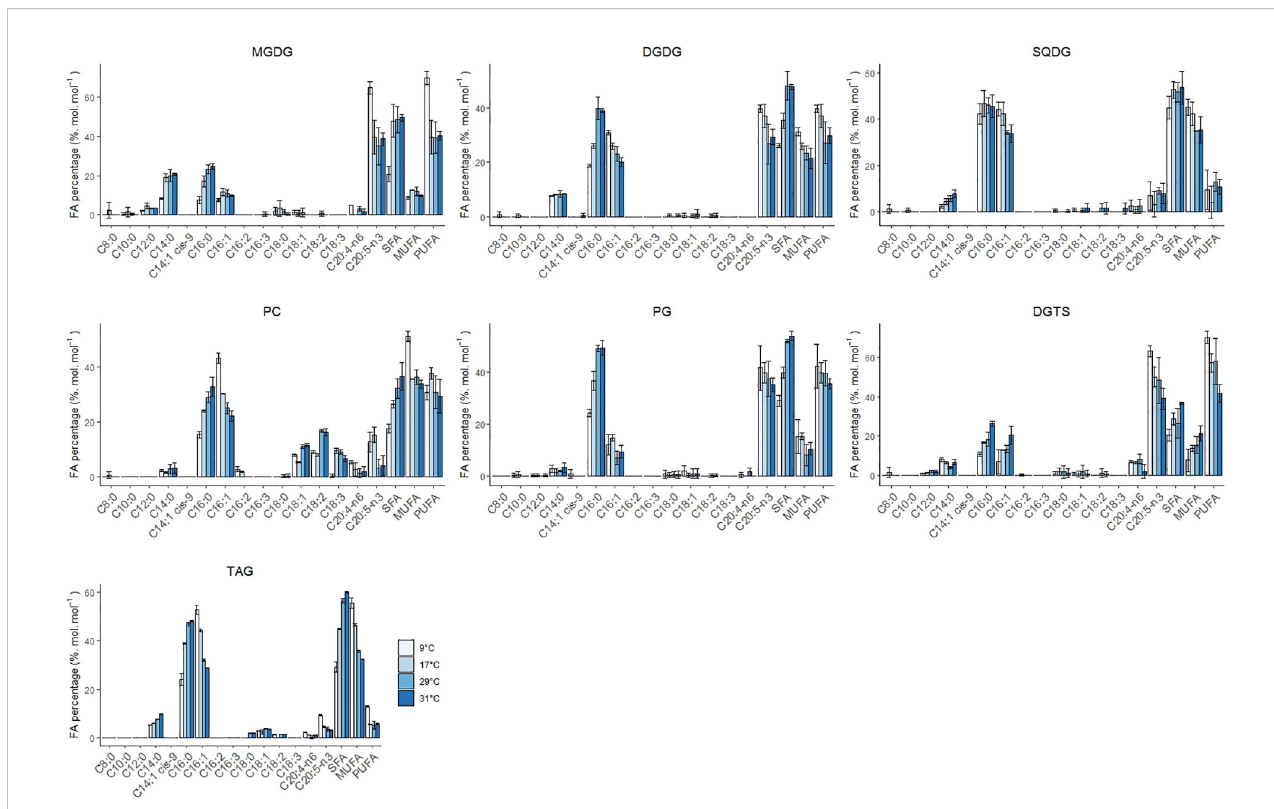
FIGURE 4 Individual FA, SFA, MUFA and PUFA composition of the lipid classes MGDG, DGDG, SQDG, PC, PG, DGTS and TAG at 9, 17, 29 and 31°C. Error bars indicate the standard deviation of three